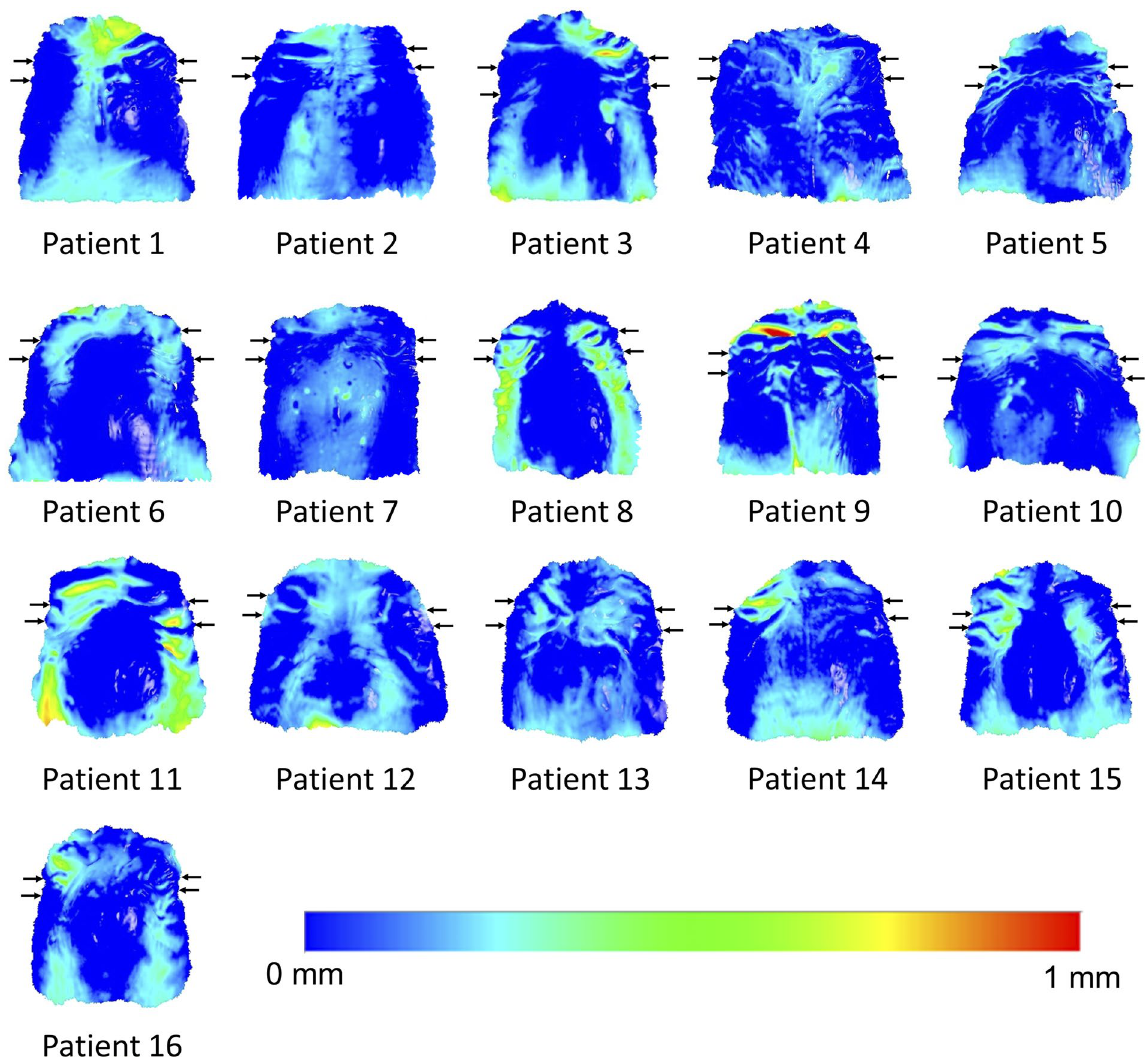
Figure 5. Color maps showing morphological differences in the palate between T0 and T1. Superimposition of T0 and T1 models of each patient in area D. The extent of congruence between serial models in each case is shown with specific color coding. In each case, the upper pair of black arrows shows the position of the second rugae and the lower pair the third rugae. Note that patients 3, 8, and 11 show reduced congruence of the superimposed models on regions that have been used as superimposition references. Patient 9 shows also reduced congruence, but on a region that was not used as a